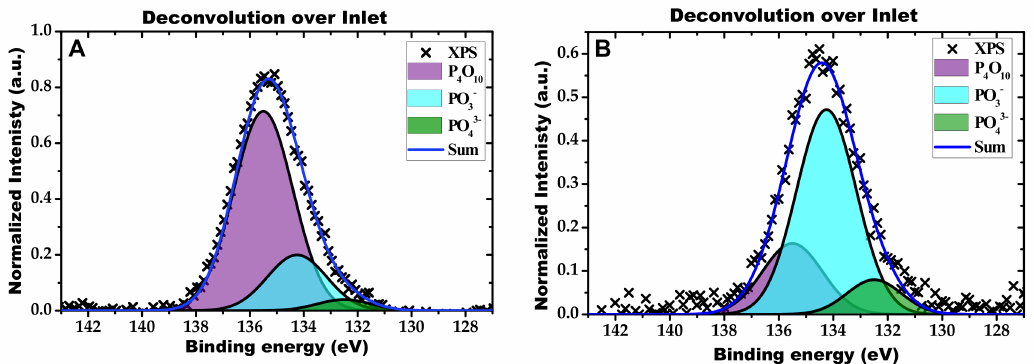
Figure 7. Deconvolution of the P 2p XPS spectra from the inlet ( A ) and middle ( B ) section of the Pt/Ba/Al 2 O 3 sample exposed to 50 vol.-ppm H 3 PO 4 for 34 h. The considered phosphorous species are P 4 O 10 , PO 3 − and PO 43 −